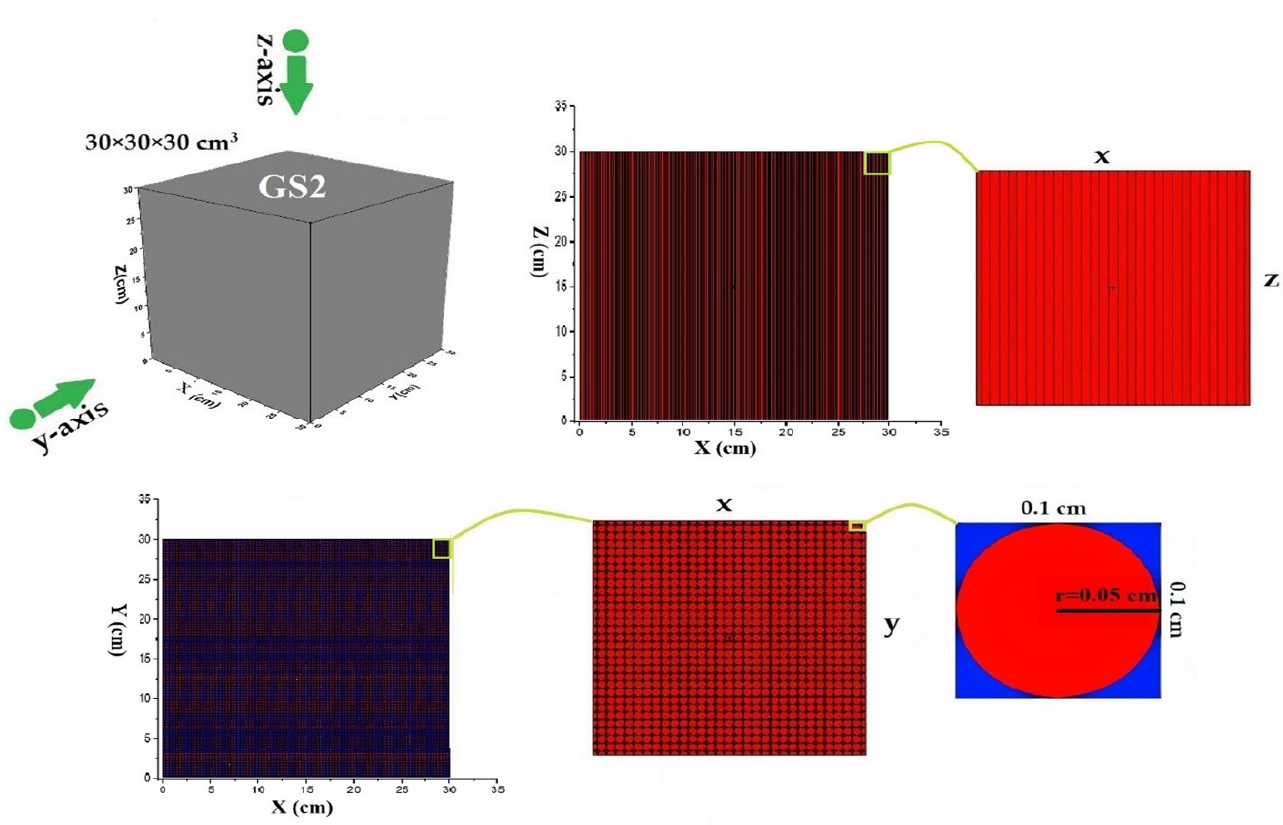
Figure 2. A geometric structure of metamaterial with cubic lattice filled with rod columns (GS2) obtained by MCNPX code.